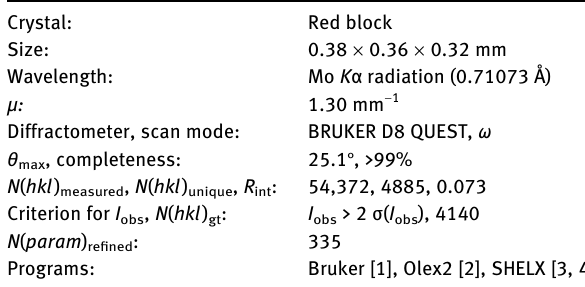
Table  : Data collection and